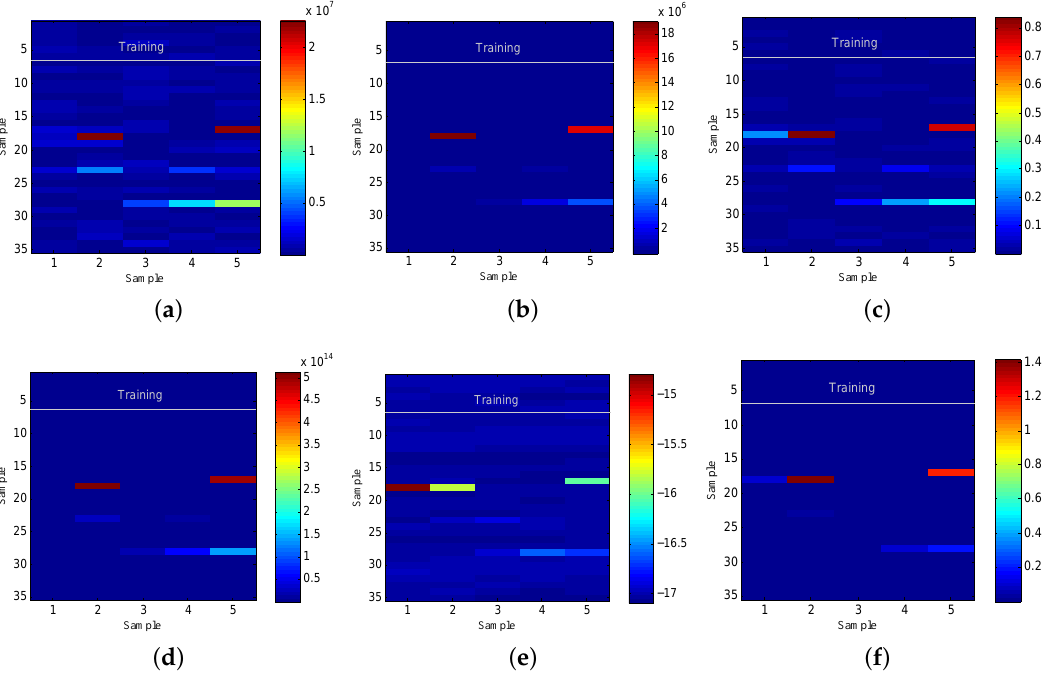
Figure 4. Metric variations on samples. ( a ) Euclidean; ( b ) Quadratic X 2 ; ( c ) Canberra; ( d ) Pearson; ( e ) Bhattacharyya; ( f ) Divergence.